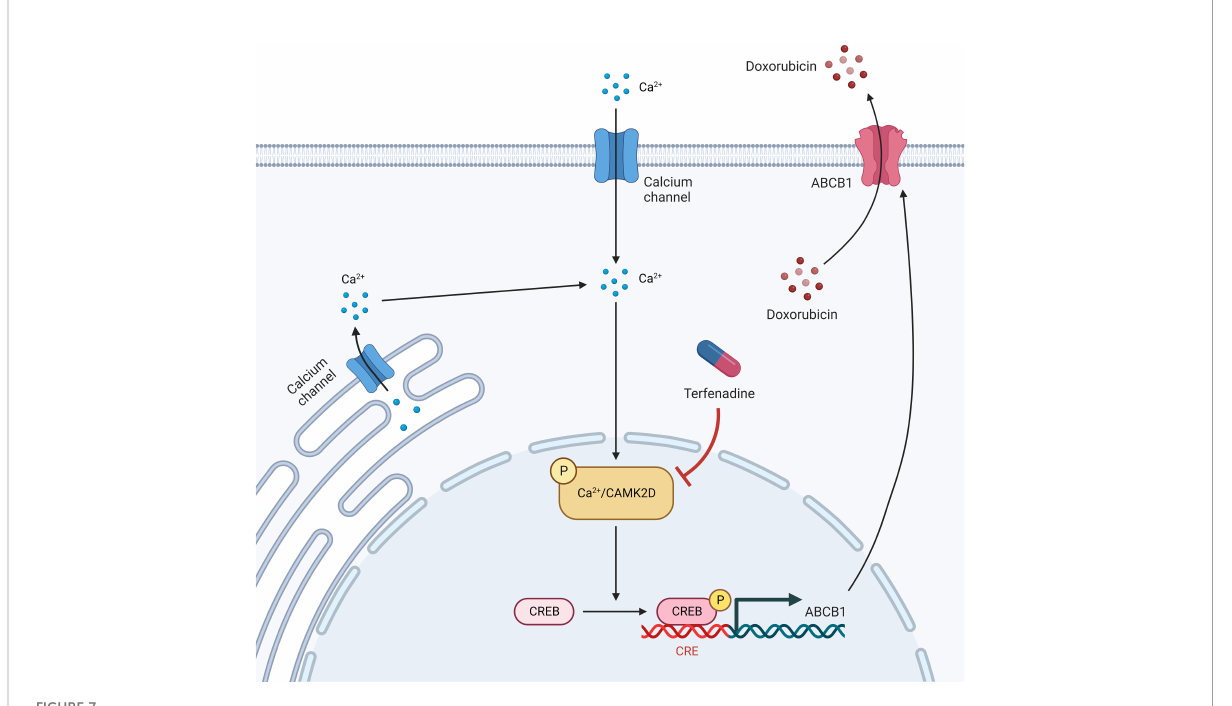
FIGURE 7 An illustration of terfenadine function in combinational treatment with